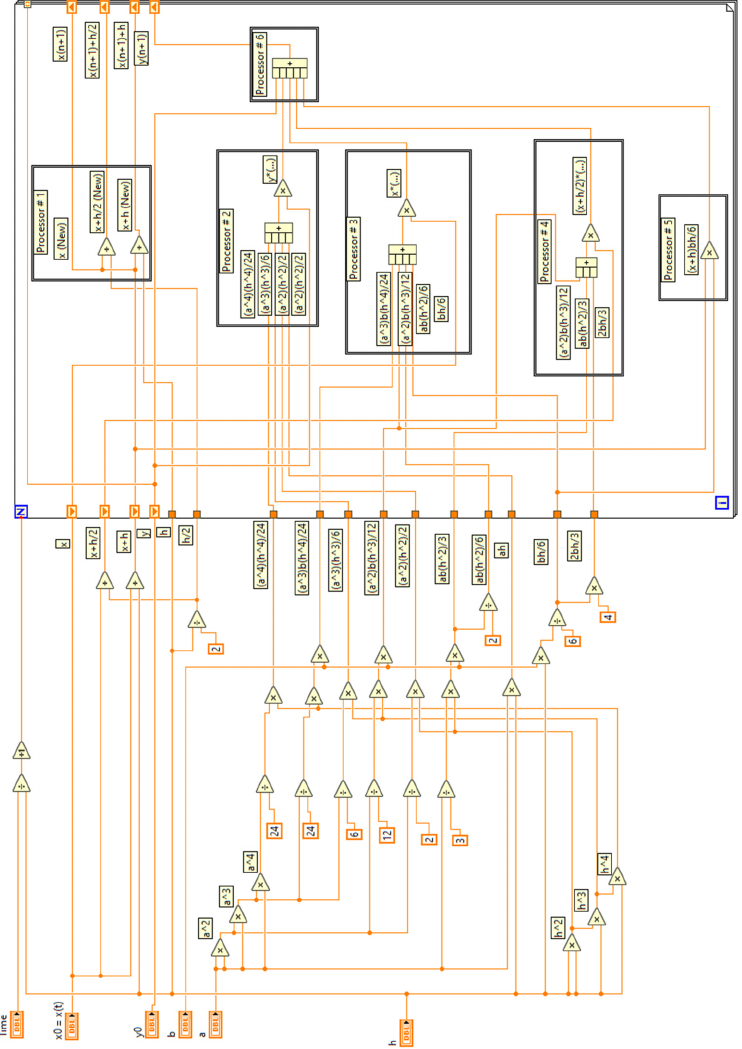
Figure A1. Graphical code for software ODE solver with parallel 5-processor computational structure for test problem (13). Double-precision floating point data type used.